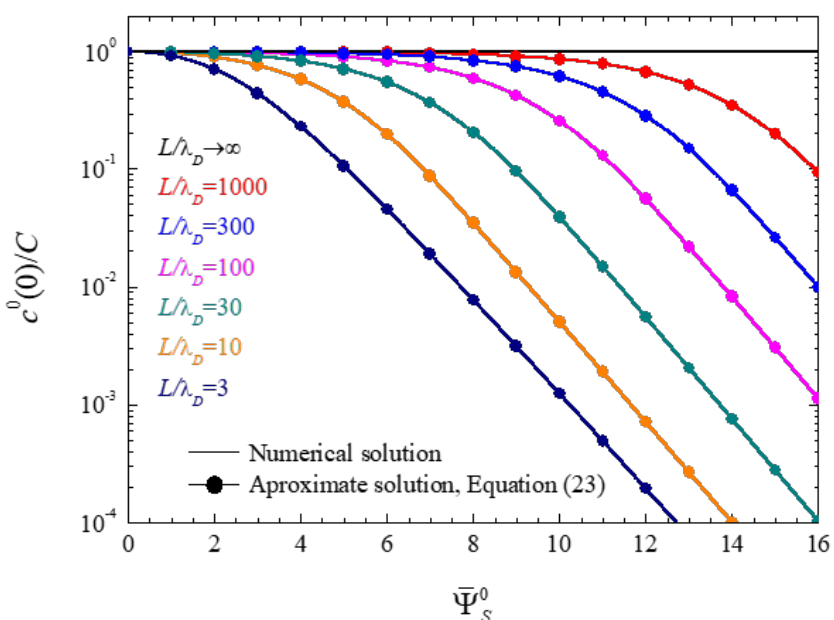
Figure 1. Ionic concentration at the central plane of closed electrolytic cells as function of the surface potential for the indicated L / λ D values.